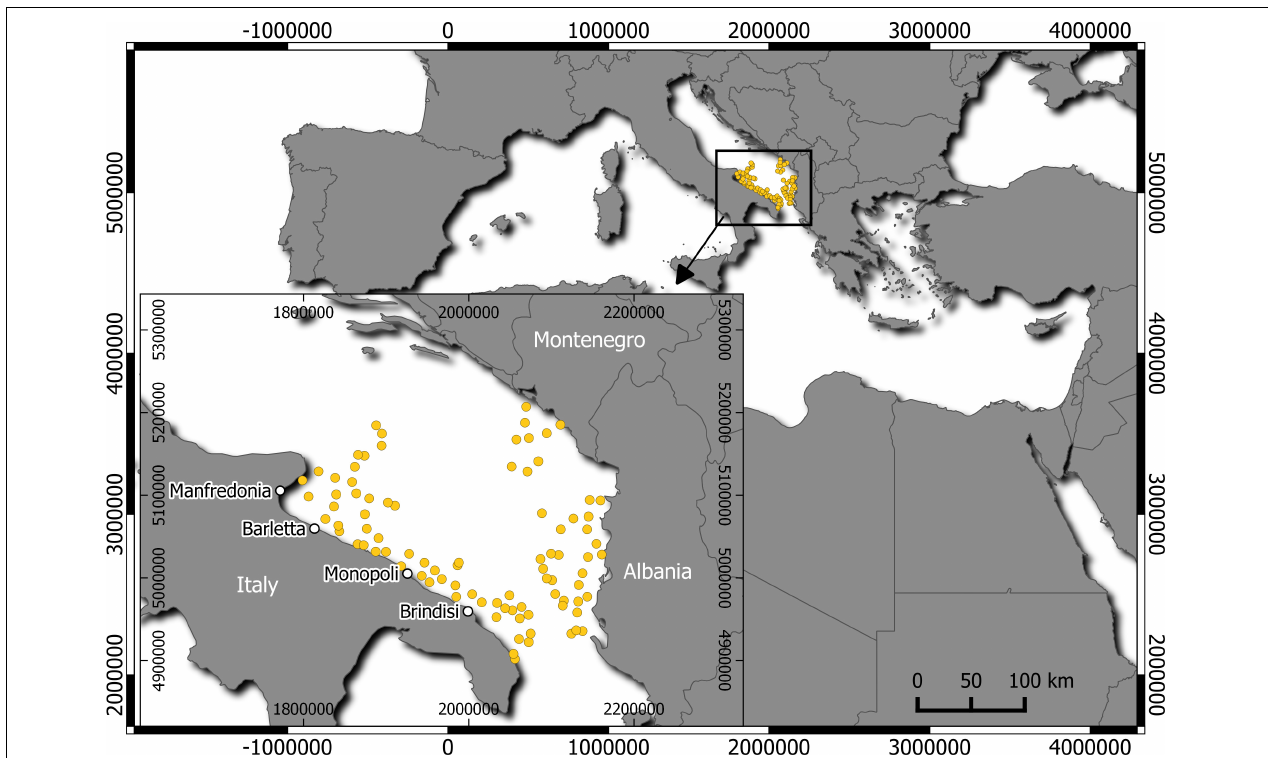
FIGURE 1 | Geographic allocation of the hauls conducted during the MEDITS trawl surveys in GSA 18 (South Adriatic Sea), indicated by yellow points. The main fishing ports along the South Adriatic coasts of Italy (inset) are indicated by white